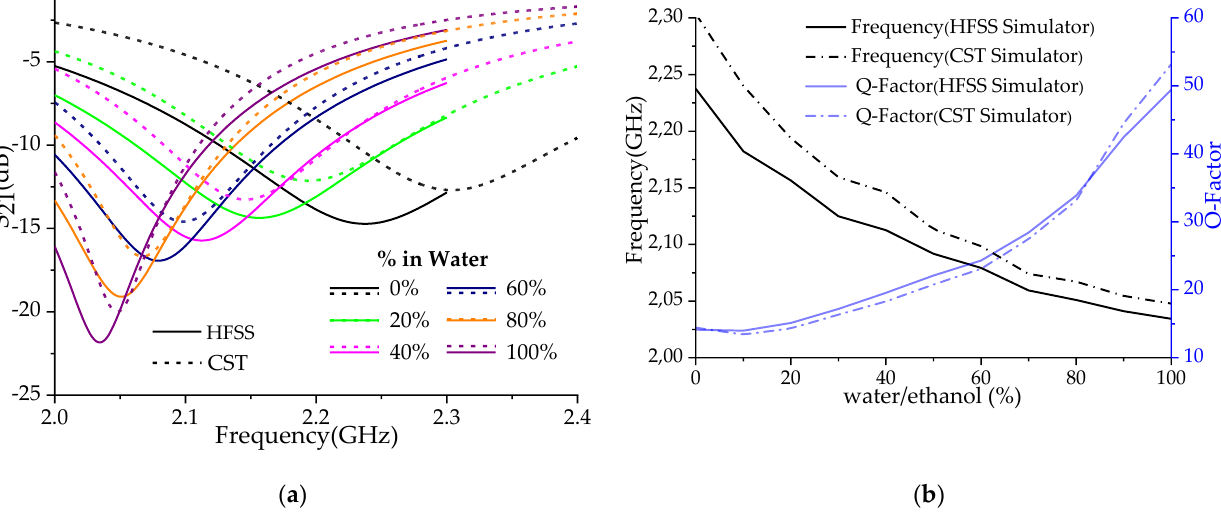
Figure 10. Simulated results: ( a ) S 21 response and ( b ) resonant frequency and Q factor for different mixture water concentrations, with r = 1.5 mm. For r = 2.5 mm, an improvement in the performance of the proposed sensor was no- ticed. The frequency band decreased and reached an average value of 2 GHz at resonance, with stable sensitivity and a slight decrease in the quality factor. In addition, the CST- and HFSS-simulated S 21 results are quite close — almost superimposed (Figure 11).